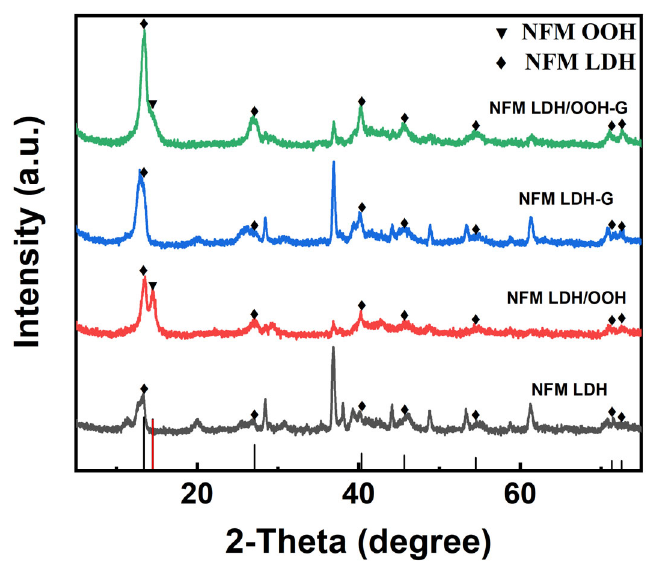
Figure 1. XRD patterns of NFM-LDH and its derivatives.